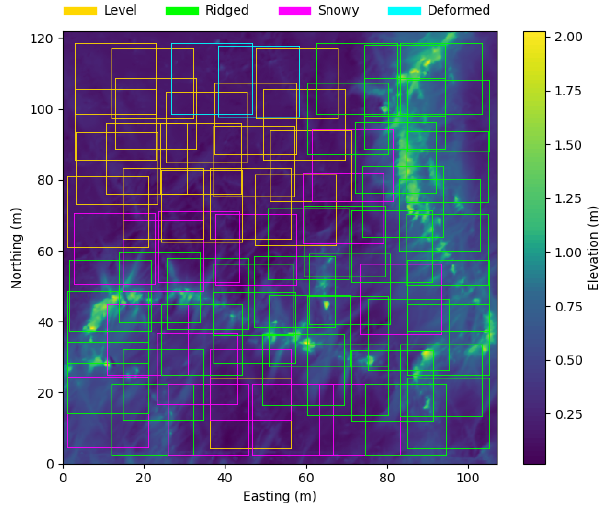
Figure 7. An example lidar scan from a station (PIP7) with the man- ually classified segments. Snow features are clearly visible emanat- ing from the L-shaped deformation. Deformed (blue) surfaces were excluded from the